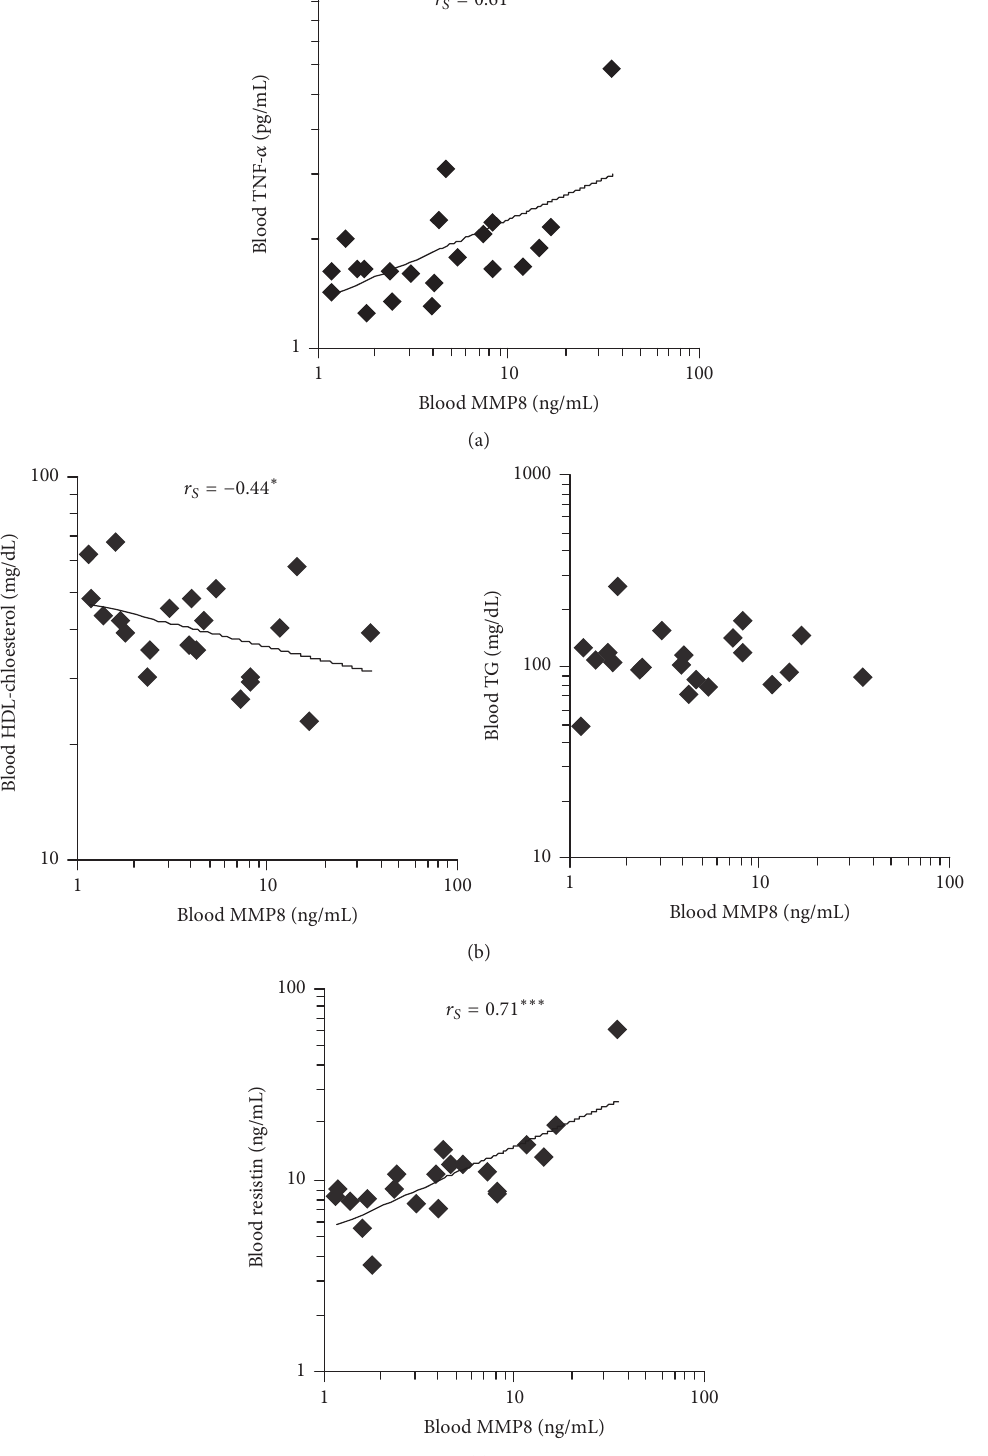
Figure 5: MMP8 blood levels correlate with metabolic alterations in AI patients. Concentrations of MMP8, TNF- 𝛼 , HDL-cholesterol, triglycerides (TG), and resistin were quantified in blood from 21 AI patients. Data were subjected to Spearman’s rank correlation analysis. 𝑟 𝑆 (Spearman’s rank correlation coefficient) is indicated ( ∗ 𝑃 < 0.05 , ∗∗ 𝑃 < 0.01 , and ∗∗∗ 𝑃 < 0.001